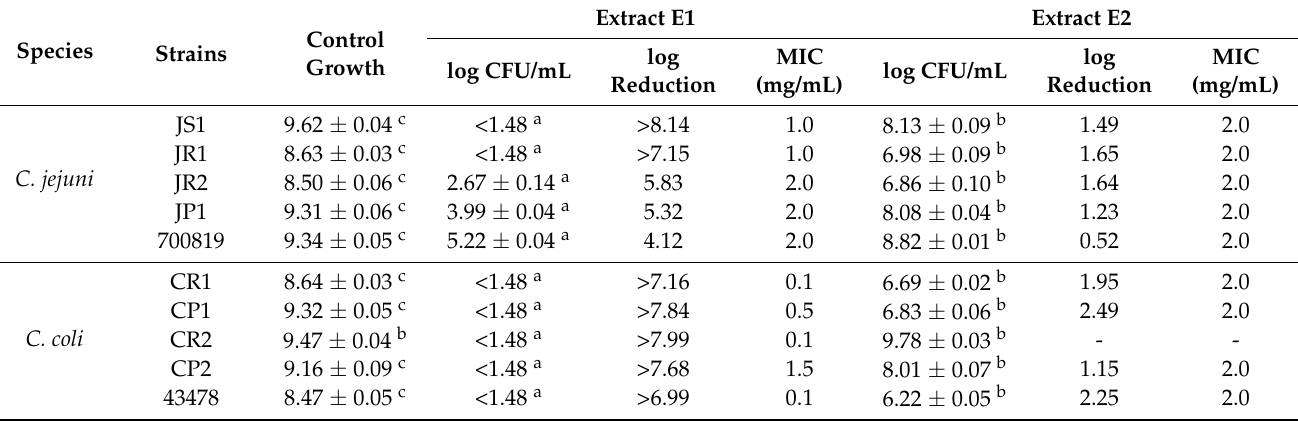
Table 3. Antibacterial activity and minimal inhibitory concentration (MIC) of olive-leaf extracts (at 2 mg/mL) against C. jejuni and C. coli strains. The results are expressed in log CFU/mL ± standard deviation (SD) ( n =